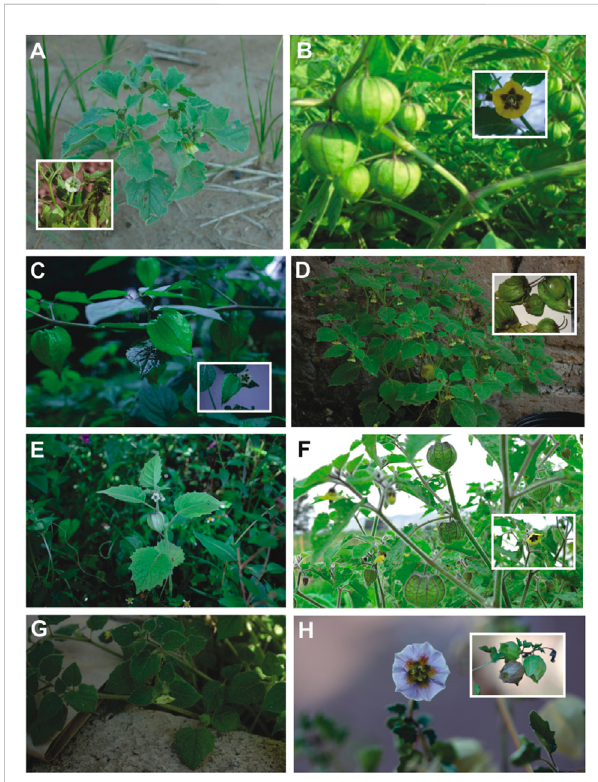
FIGURE 12 Details of fl owers and fruits of Physalis spp. (A) P. patula , (B) P. philadelphica , (C) P. porrecta , (D) P. pringlei , (E) P. pruinosa , (F) P. pubescens , (G) P. queretaroensis , (H) P.